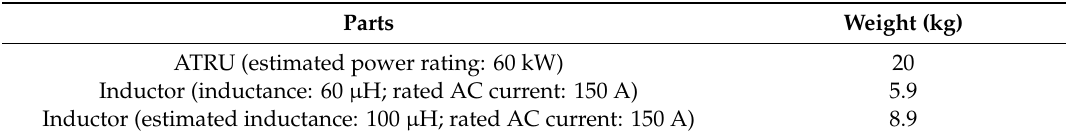
Table 7. Weight estimations for magnetic components used in different configurations.